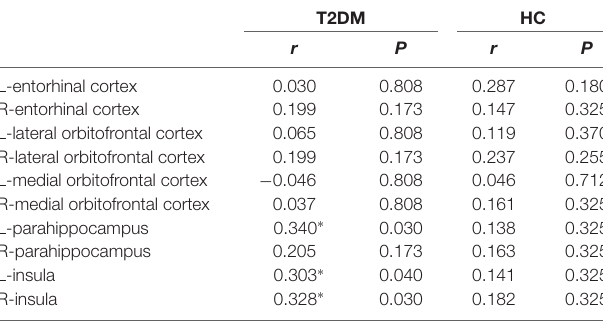
TABLE 2 | Correlation analysis of CSIT-OI scores and cortical thickness of the ROI.